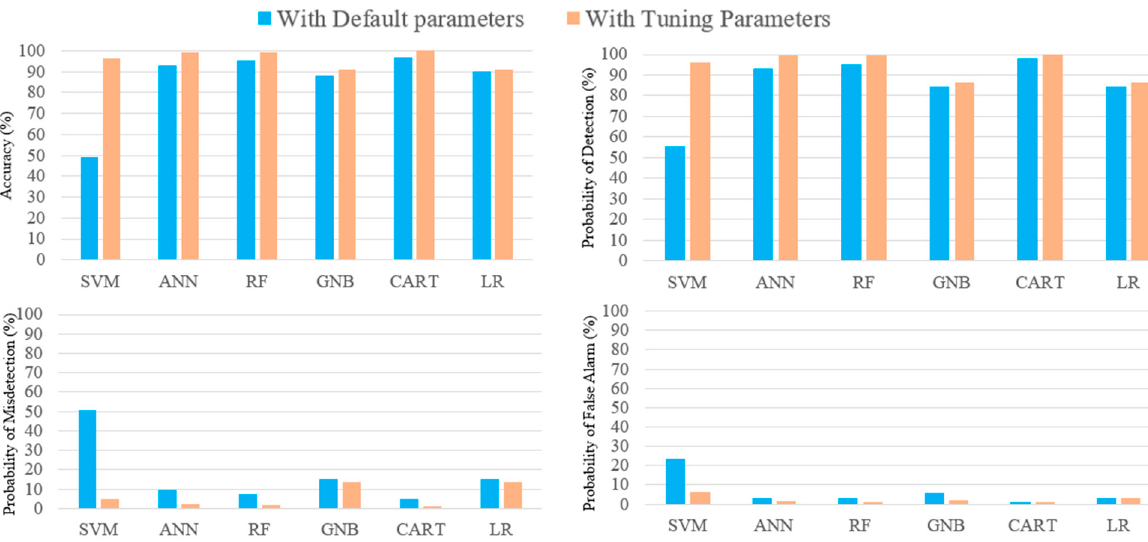
Figure 4. Impact of hyperparameter fine-tuning on model performance.